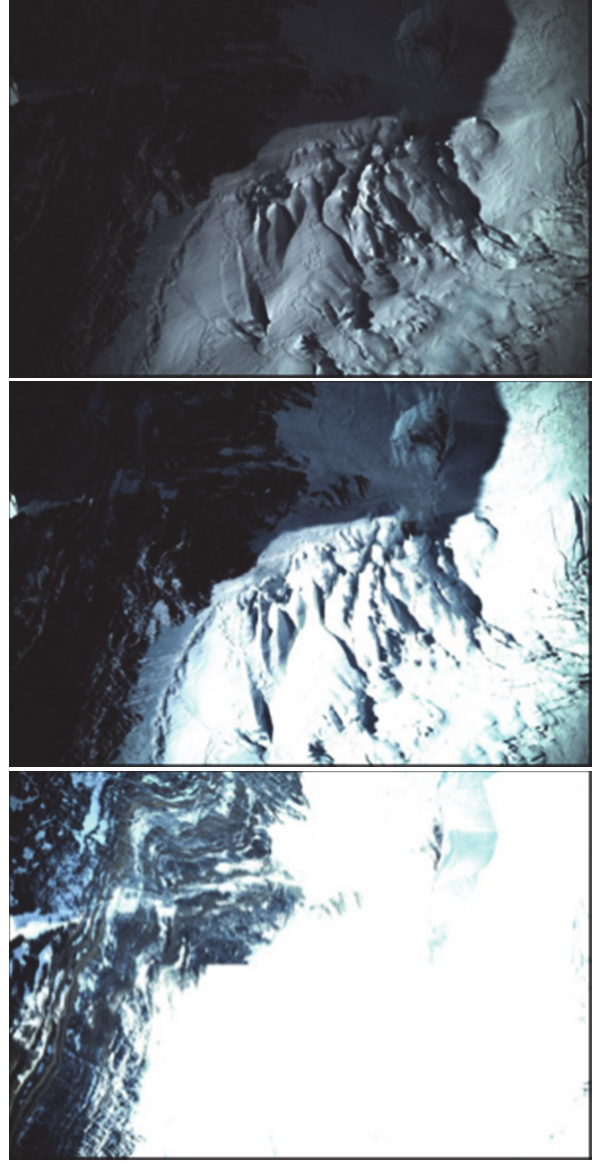
Figure 9. High contrast scene, a series of consecutive 12 bit aerial photos with different integration times. All three images have to be considered to reproduce all